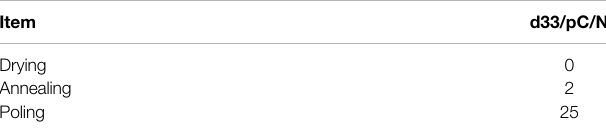
TABLE 2 | Comparison of d 33 of PVDF-TrFE fi lms after different processing